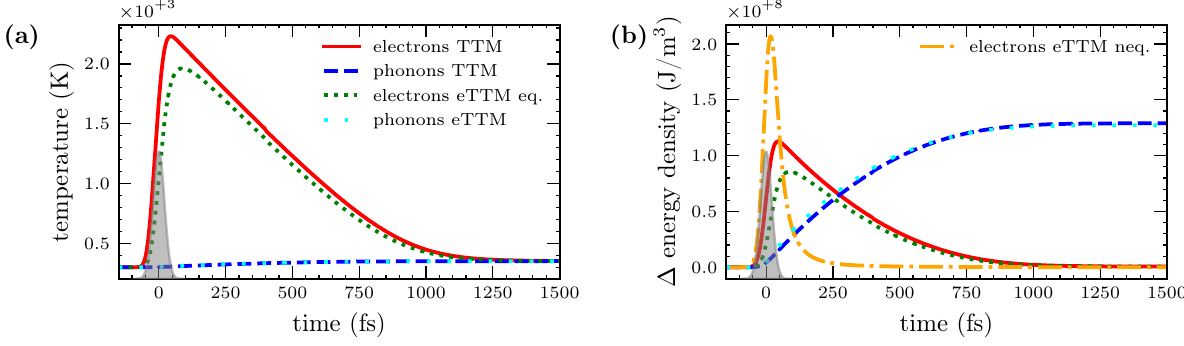
Figure 2. ( a ) Temperatures of electrons and phonons. The results of a TTM simulation are compared to the results of an eTTM simulation. The shape of the laser pulse is sketched in gray. It is visible that the maximum temperature of the electrons in the TTM simulation is higher than the maximum electron temperature obtained with the eTTM simulation. At this stage, part of the energy is kept in the non-thermal electrons of the eTTM. ( b ) Energy density of all subsystems of TTM and eTTM in dependence on time, plotted as difference to the initial values. Due to the connection between energy density and temperature, the dynamics resemble the temperature dynamics. Additionally, the energy density of the non-equilibrium electrons in the eTTM is shown in the yellow dashed-dotted line. It is clearly visible that non-equilibrium electrons are generated directly by the laser and thermalize in the next hundreds of